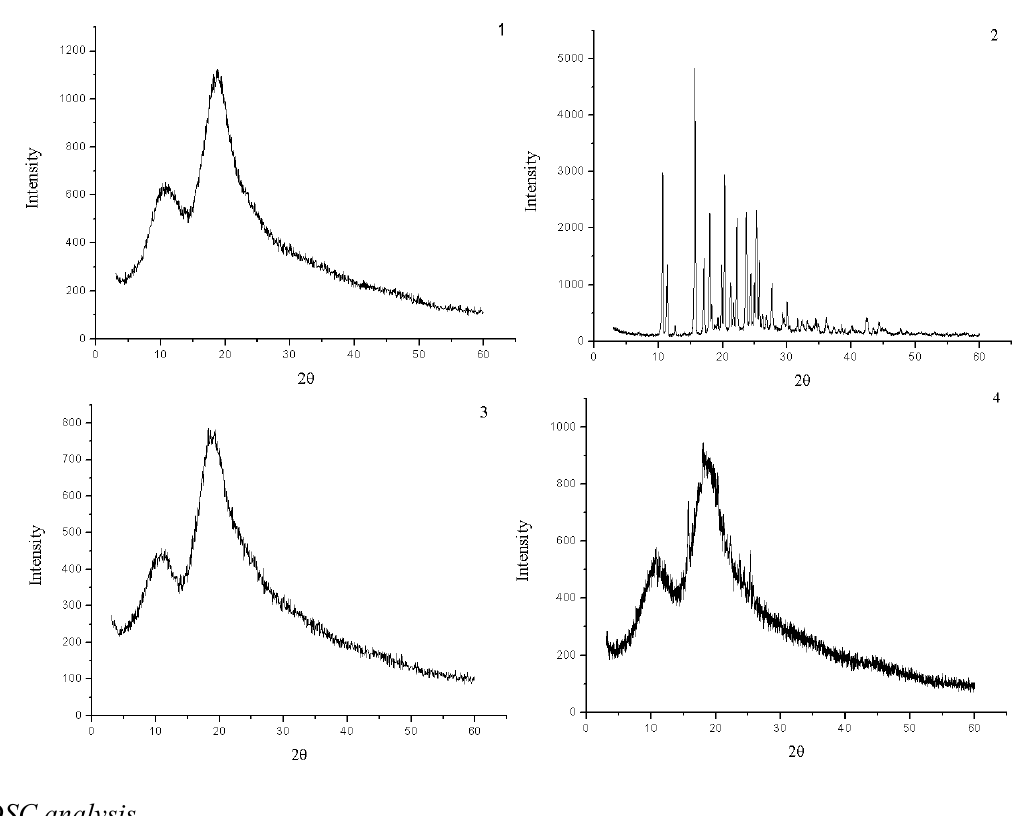
Figure 4. X-ray diffraction patterns of HP- β -CD ( 1 ), naringenin ( 2 ), complex of naringenin and HP- β -CD ( 3 ) and physical mixture of naringenin and HP- β -CD ( 4